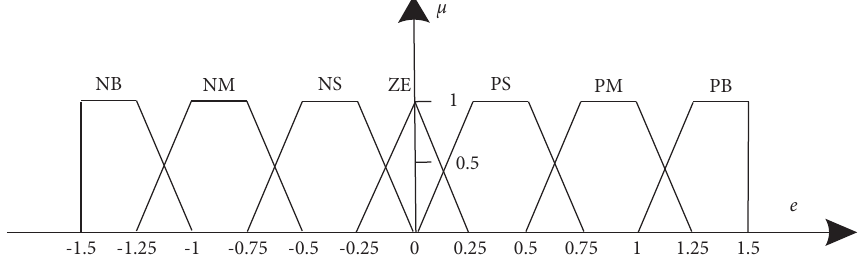
Figure 8: Membership function of water quantity